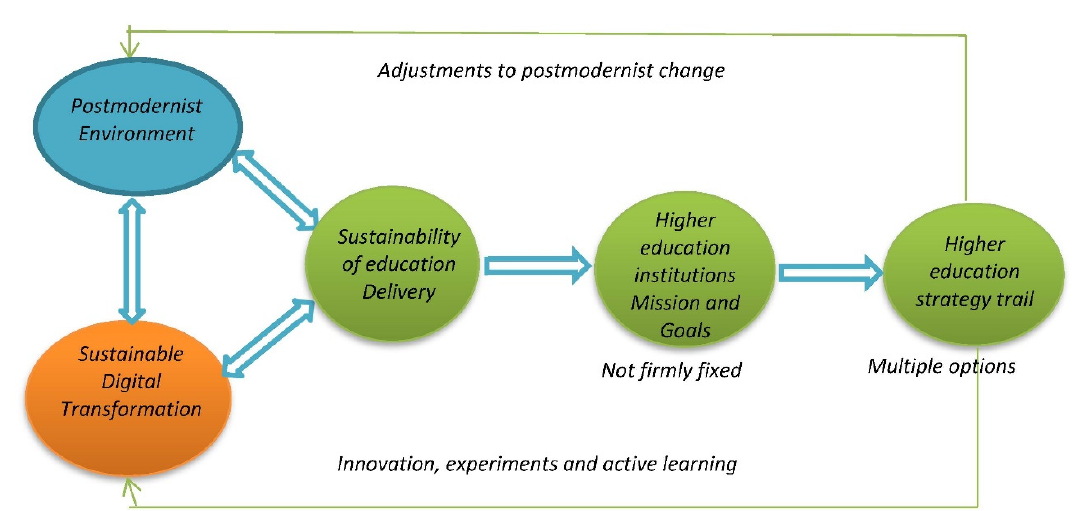
Figure 5. The postmodern-digital future . Source: Based on Argyris (1977), Mintzberg (1987), Quinn (1980), Senge (1990), Lynch (2018) and Whittington et al.